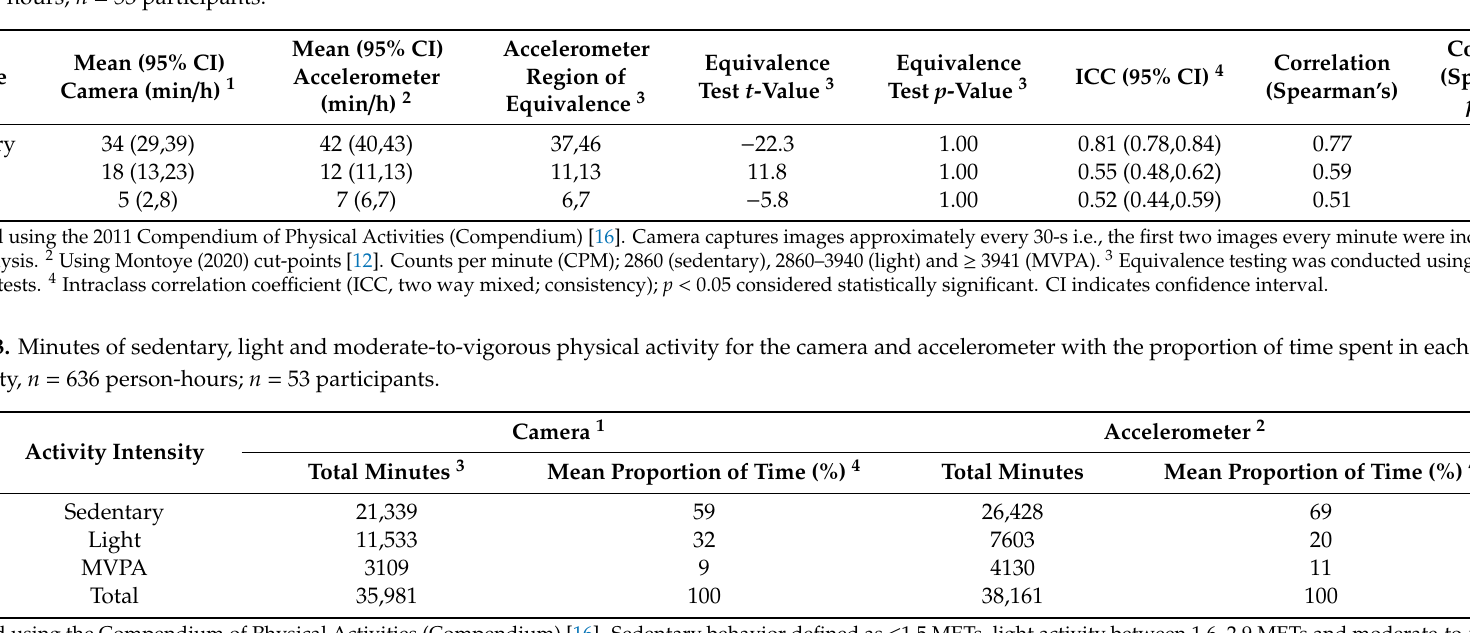
Table 2. Agreement between camera and accelerometer data by means (95% CI), equivalence testing, intraclass correlation coe ffi cient and Spearman’s rho, n = 636 person-hours, n = 53 participants.